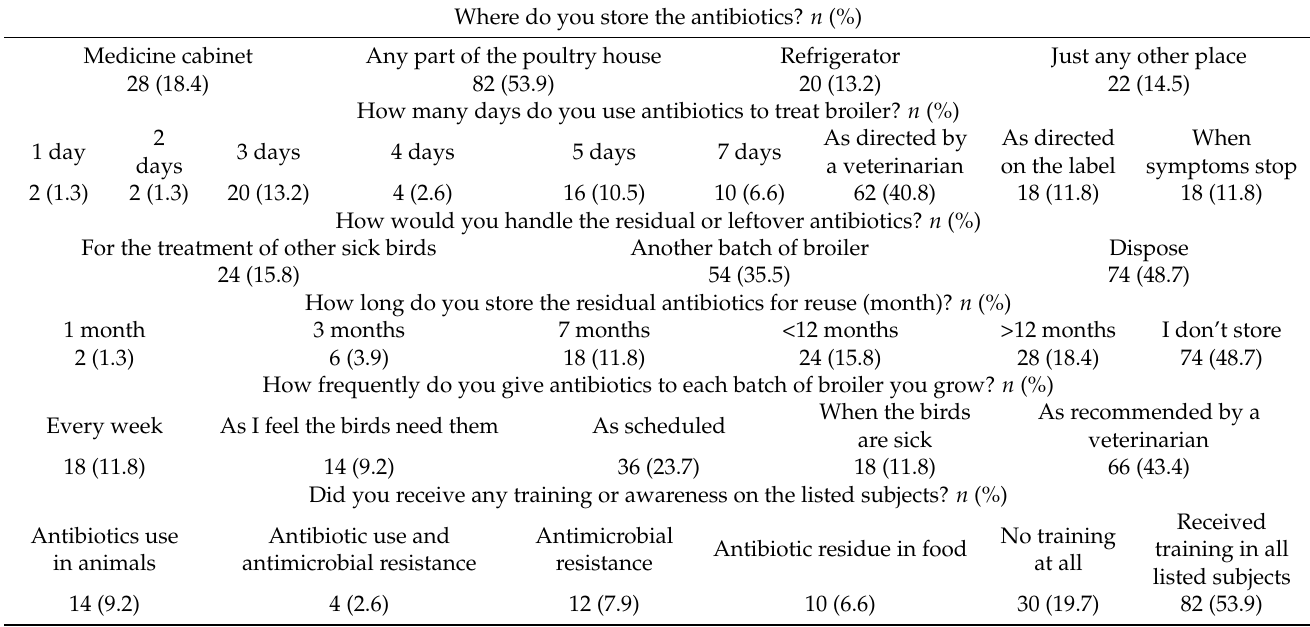
Table 6. Practice of antibiotics use in response to regulation ( n =